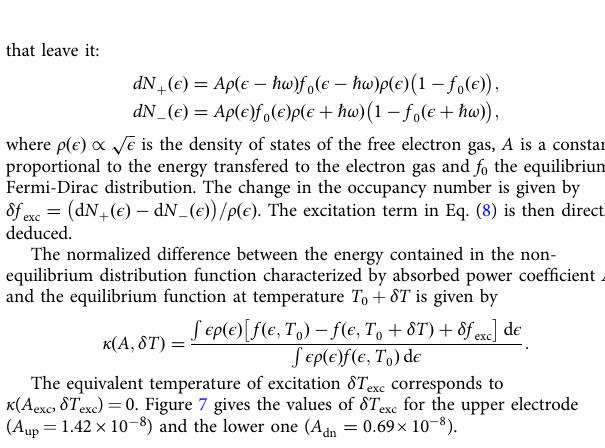
Fig. 7 Normalized difference κ ( A , δ T ) between the energy contained in the non-equilibrium distribution function and the equilibrium function. κ ( A , δ T ) for the equivalent temperature of excitation in the upper electrode characterized by a power coef fi cient A up = 1.42 × 10 − 8 (orange line) and the lower electrode characterized by a power coef fi cient A dn ¼ 0 : 69 ´ 10 (cid:2) 8 (purple